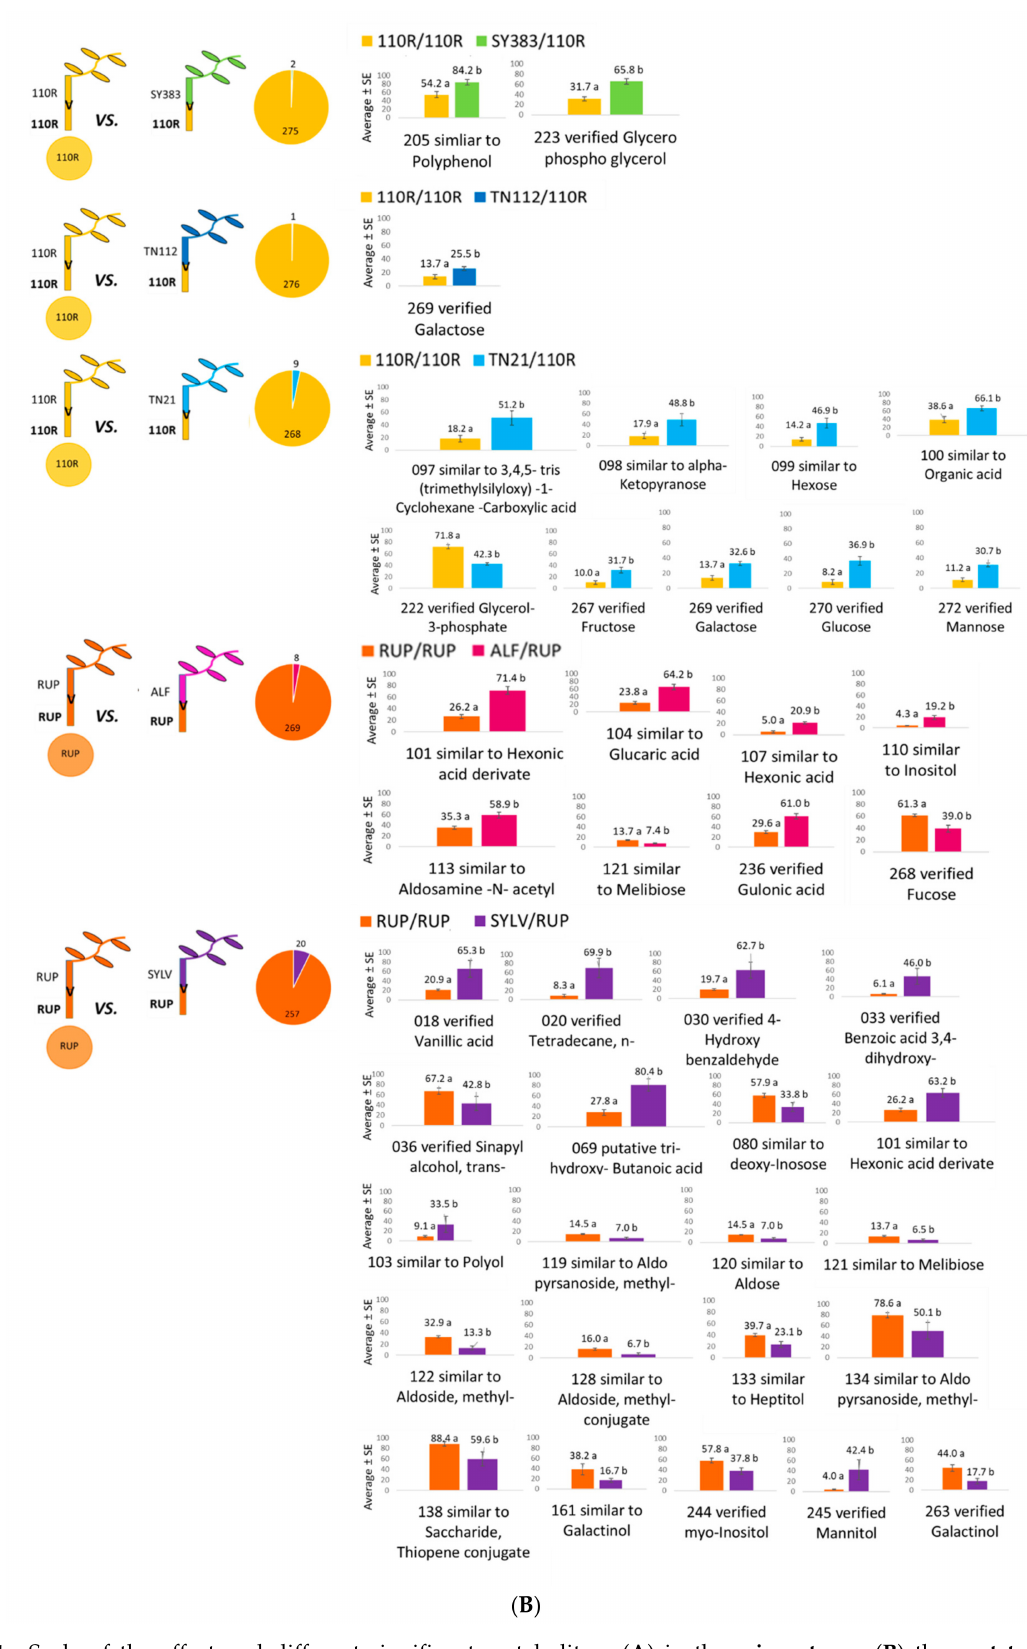
Figure 4. Scale of the effect and different significant metabolites: ( A ) in the scion stems ; ( B ) the rootstock stems of homografts, upon grafting with a heterologous partner. Scale of the effect of a heterologous grafting partner in the